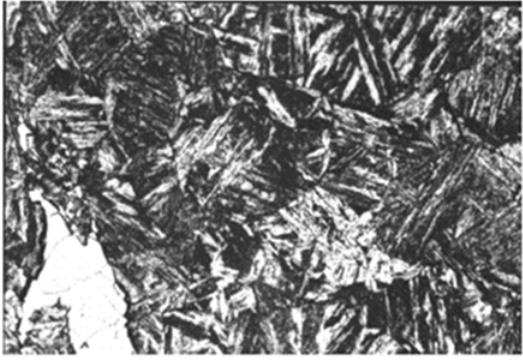
Fig. 5 . Microstructure of aging specimens at temperature 500 ° C and aging time 5 hrs 200 X